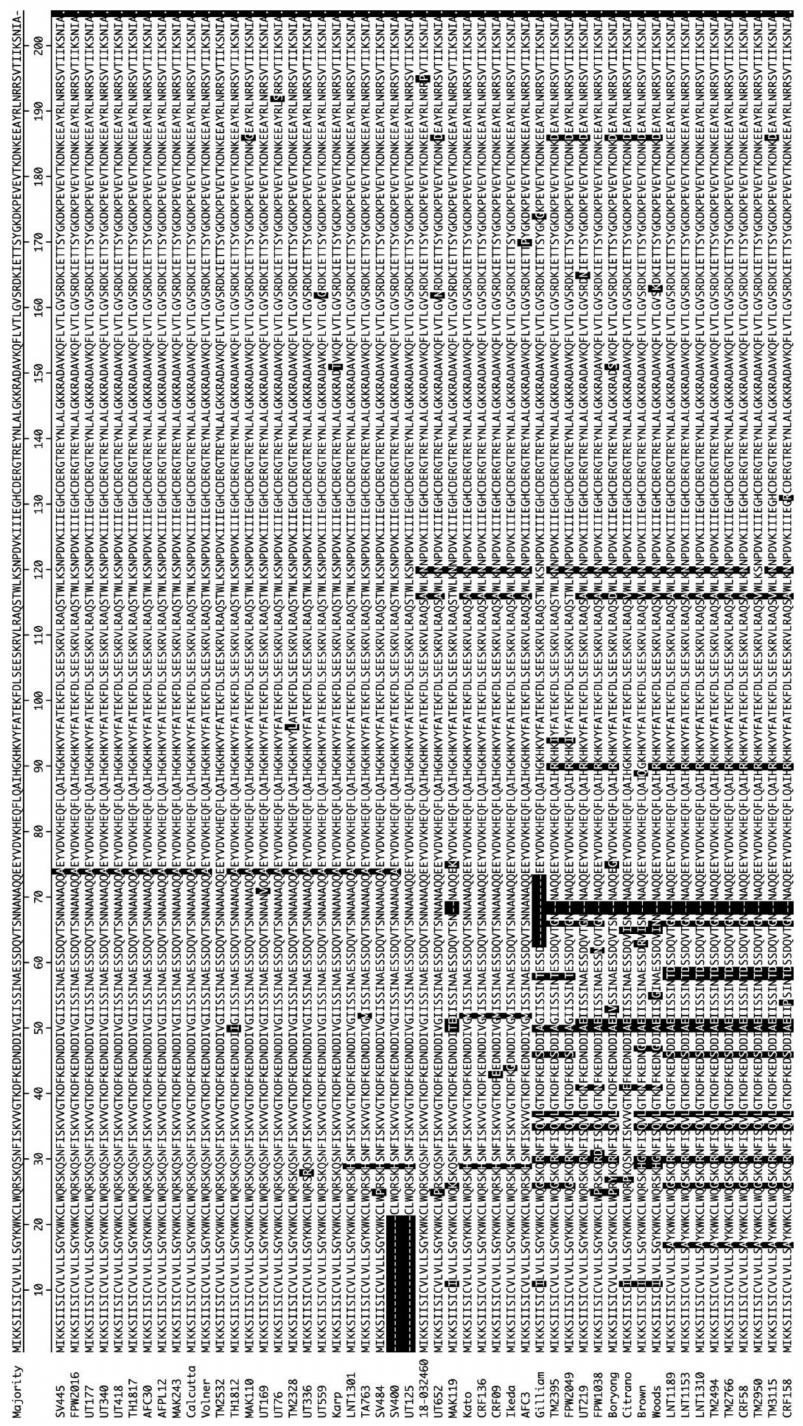
Figure 3. Alignment of translated O. tsutsugamushi isolate OmpA sequences. Presented is a ClustalW alignment of the translated amino acid sequences of all 51 O. tsutsugamushi isolates in this study. Amino acid differences relative to the majority (consensus) sequence are denoted by black-shaded white text. Sequence gaps relative to the majority are indicated by dashes. Residues 1–21 for SV400 and UT125 could not be predicted because ompA could be amplified by OTT_RS06375-64F/615R, but not